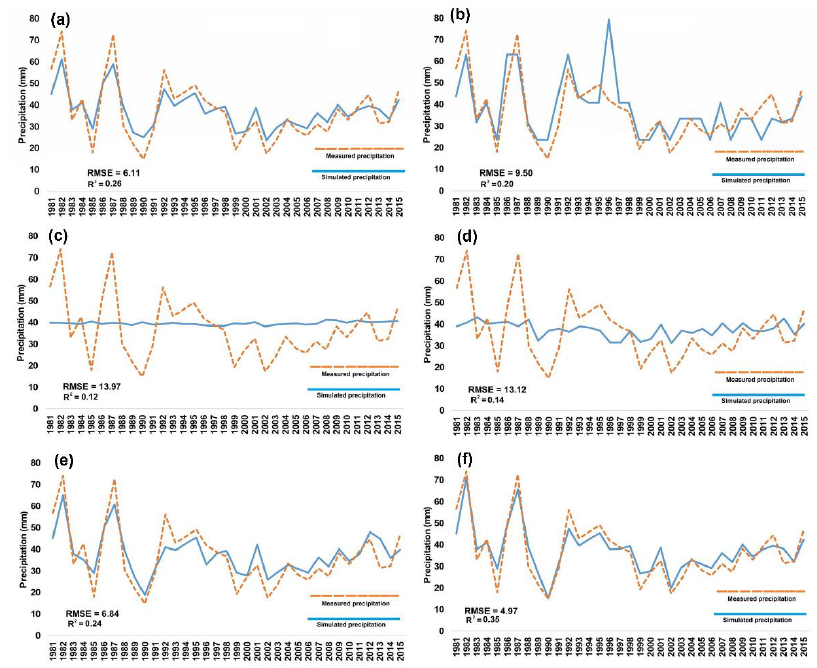
Figure 8. Time series of measured monthly precipitation amounts from the Climatic Research Unit (CRU3.23TS) dataset compared to simulated precipitation amounts obtained from the various machine learning (ML) models including ( a ) Random Forest, ( b ) Decision Tree, ( c ) ANN, ( d ) DNN, ( e ) Gboost, and ( f ) XGboost during the dry period. Root mean square error (RMSE) values indicate the accuracy of the developed ML models.